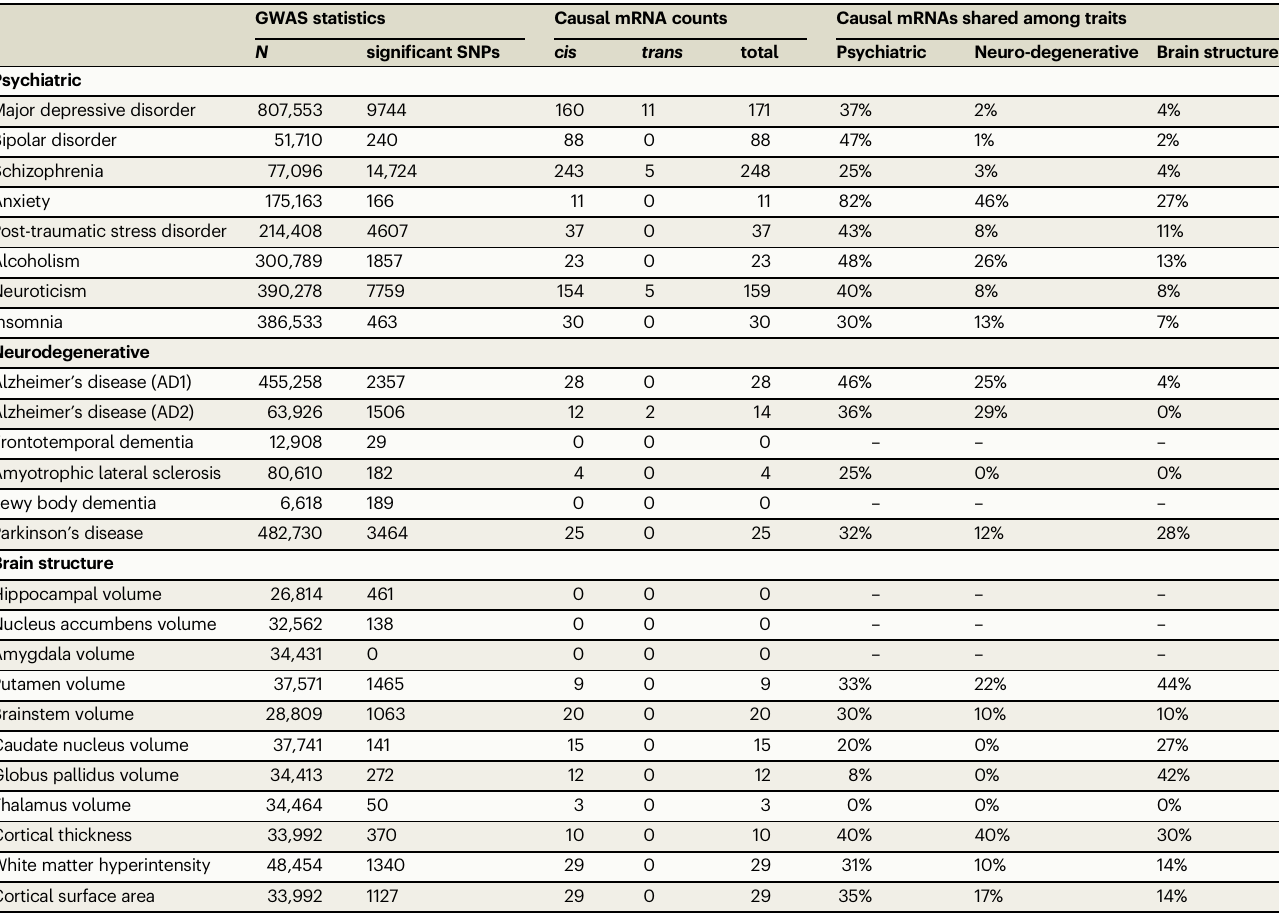
Table 2 | Summary of the source GWAS and number of causal mRNAs identi fi ed through TWAS, SMR/HEIDI, and